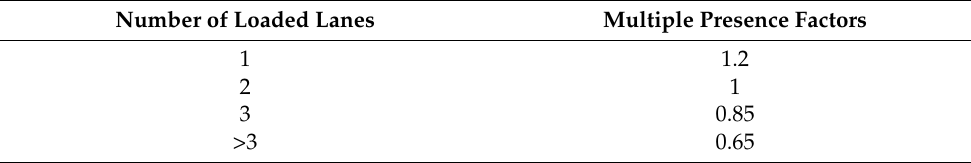
Table 2. Multiple presence factors